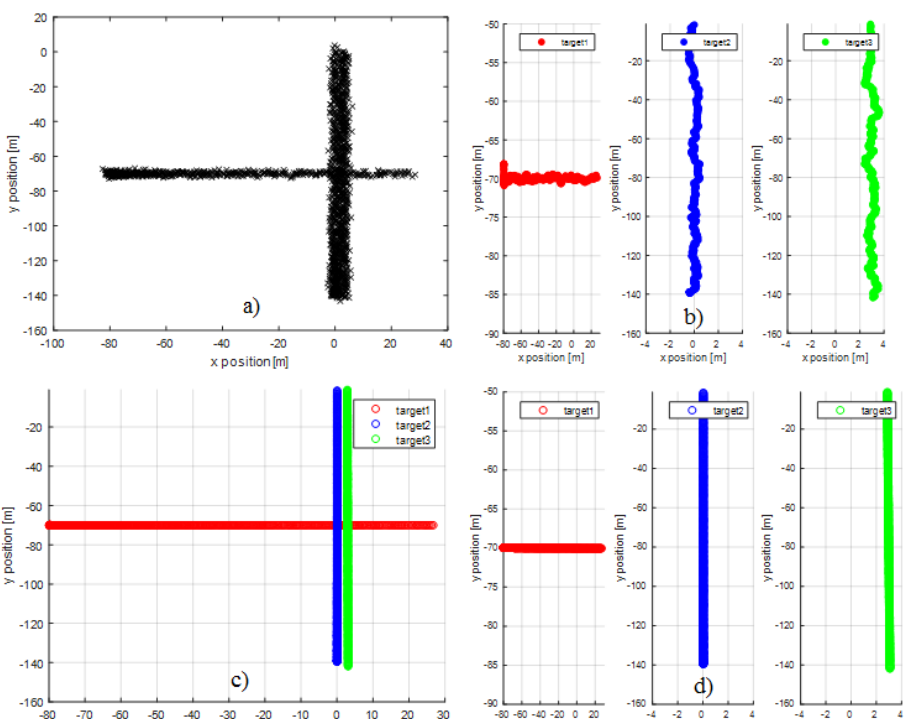
Figure 4. Partial and final results of the second experiment with simulated data, [6]: ( a ) spatial spreading of targets after data association; ( b ) the effect of Kalman filtering; ( c , d ) the effect of the explicit polynomial fitting method.